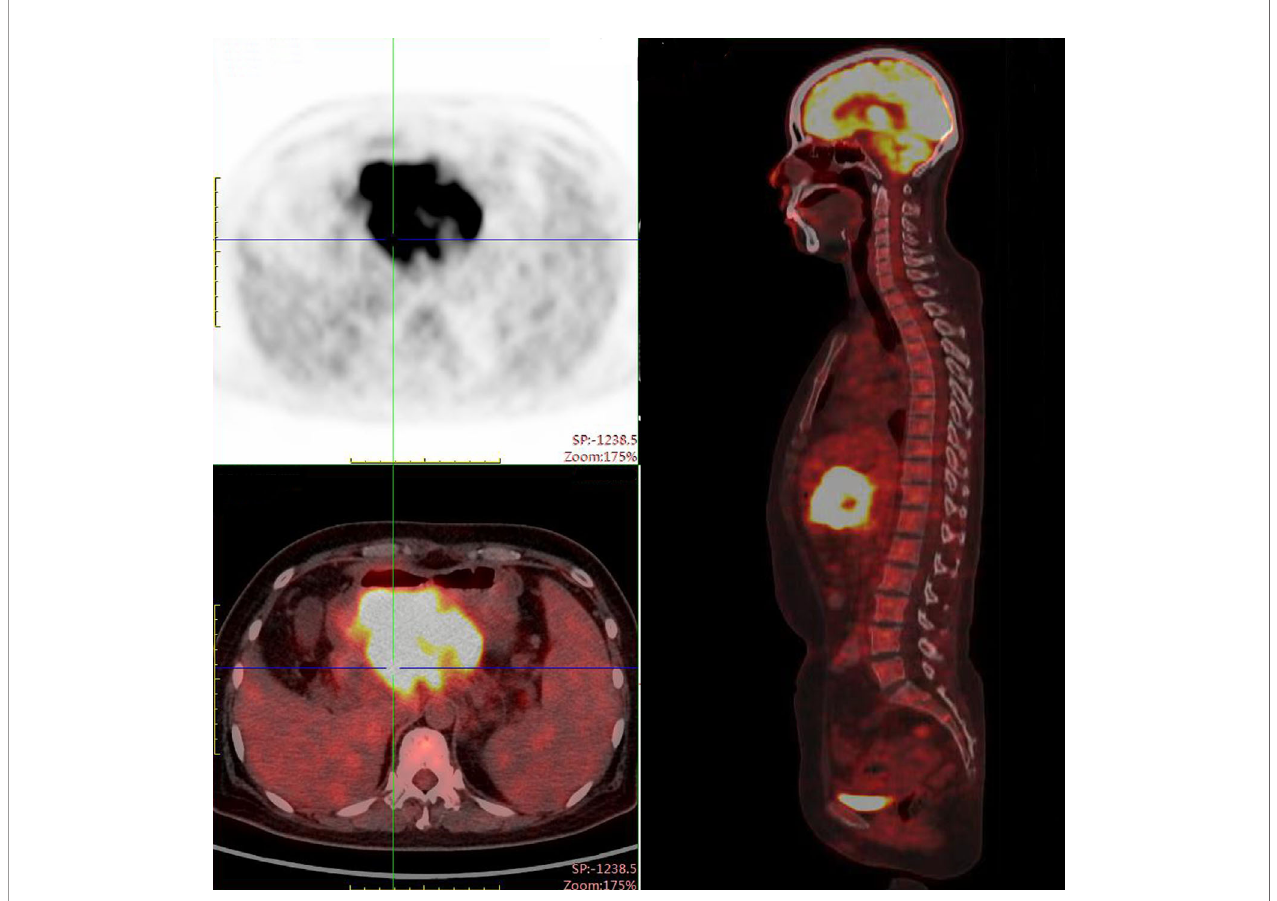
FIGURE 2 | PET-CT scan demonstrated a mass measuring 105 x100 x 70 mm with peripheral elevated FDG avidity in the neck of the